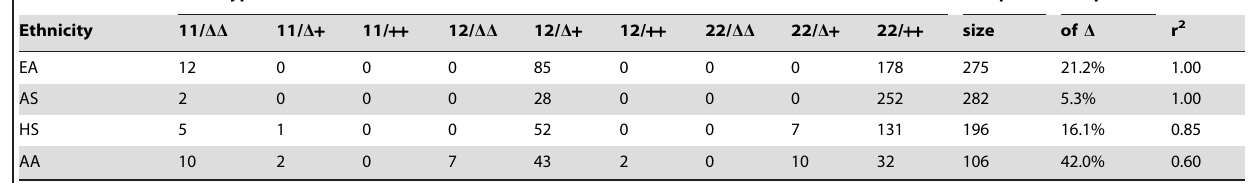
Genotype combination between rs6677604 and CFHR3-1